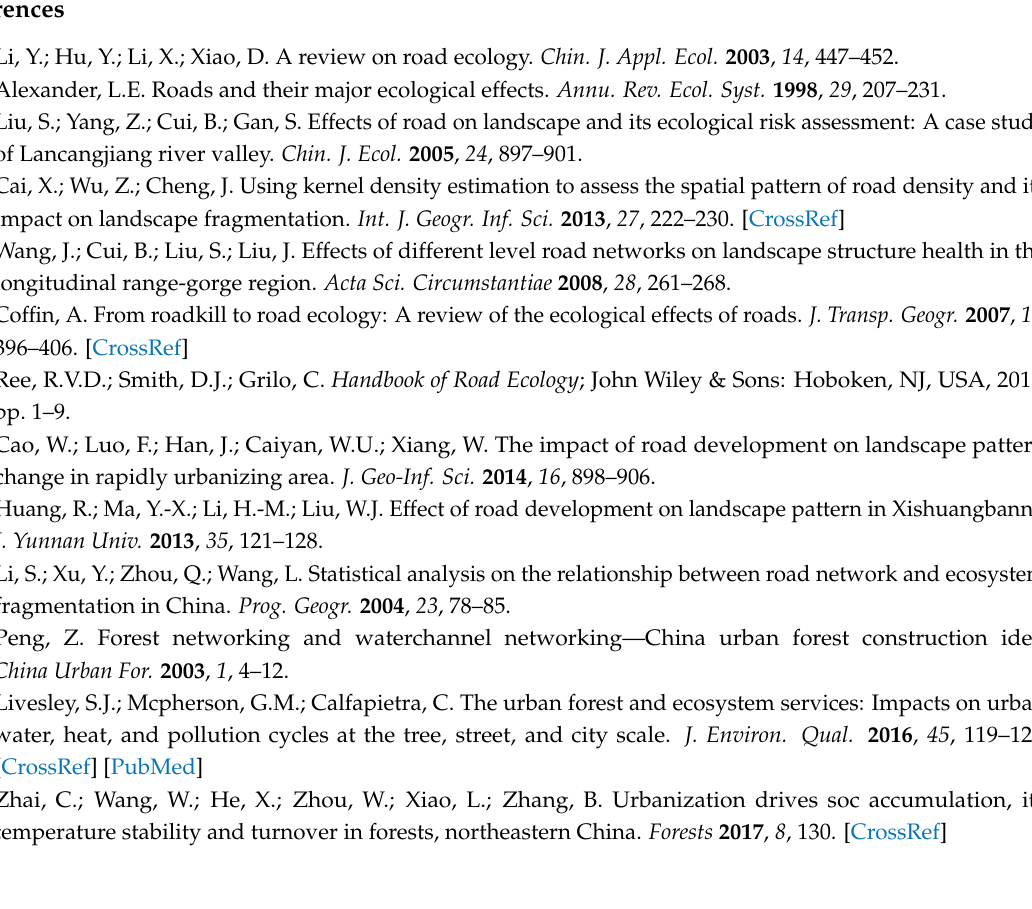
Figure S1: QQ-plots for the raw data, Figure S2: QQ-plots for the transformed data, Figure S3: Histogram of frequency distribution of all data, Figure S4: Regression analysis results between road density, forest structural-taxonomic attributes and landscape metrics, Figure S5: Residual figure for residual homogeneity and heteroscedasticity diagnosis, Table S1: Field-surveyed raw data quality check for all figures and tables used in this paper, Table S2: Stepwise regression and model diagnosis results in Low RD region and medium to heavy RD